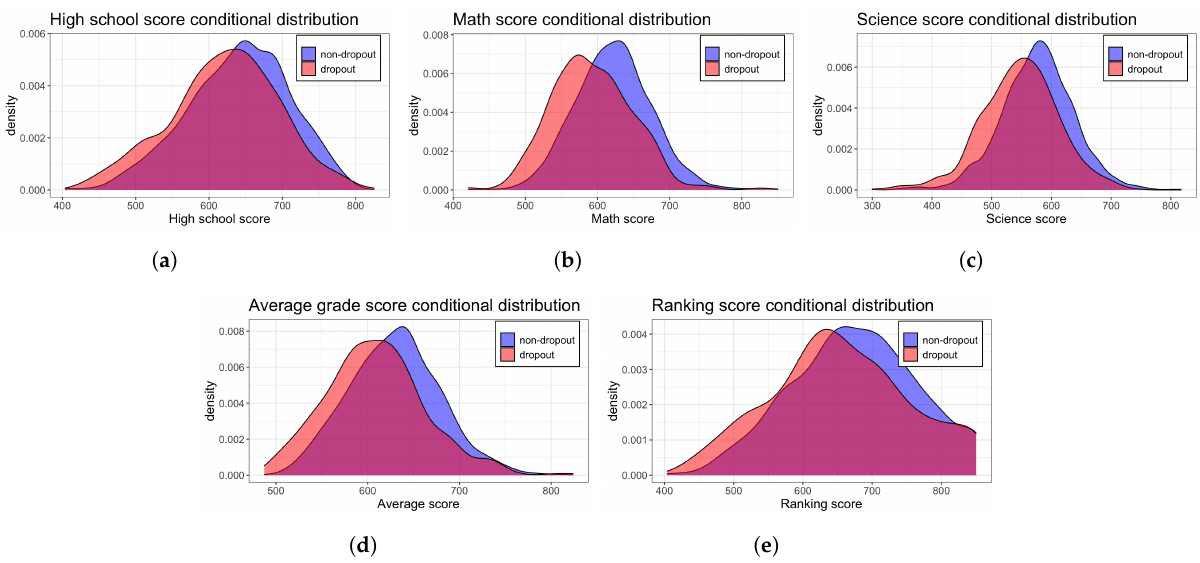
Figure 2. Score conditional distributions based on the DROPOUT variable, with respect to each variable within the Universidad de Talca dataset. ( a ) Variable nem. ( b ) Variable mat. ( c ) Variable optional. ( d ) Variable pps. ( e ) Variable